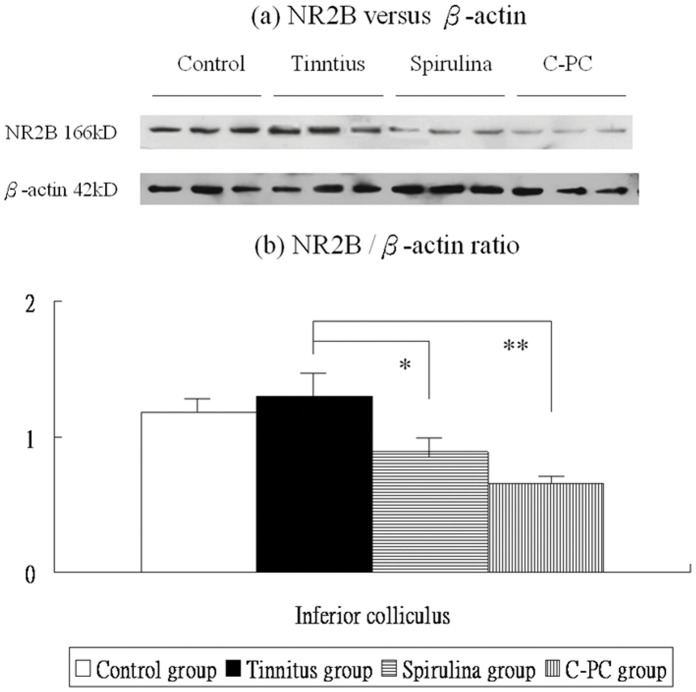
The levels of NR2B protein expression in the IC (a,b).There are significant differences in these levels among the four groups. The NR2B mRNA expression were not significantly higher in the salicylate group than the control group. Compared to the tinnitus group, the Spirulina group (*) or C-PC group (**) exhibits significantly reduced NR2B protein levels in the IC.